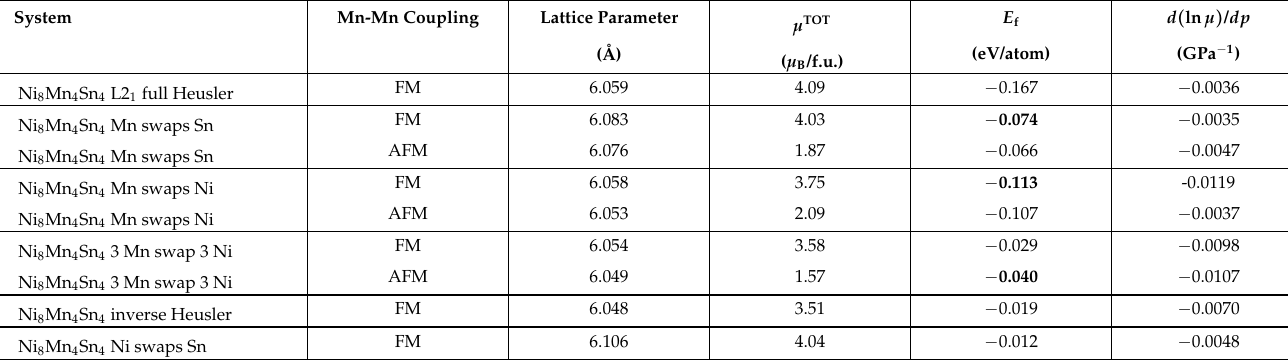
Table 1. Computed properties of the studied systems including the lattice parameters of the 16-atom supercells, formation energies E f (in eV per atom), total magnetic moments µ TOT (in µ B per 4-atom formula unit, f.u.) and its pressure derivatives d ( ln µ ) /d p . States with a lower formation energy (from the pair of either FM-coupled or AFM-coupled one) have their formation energy printed in